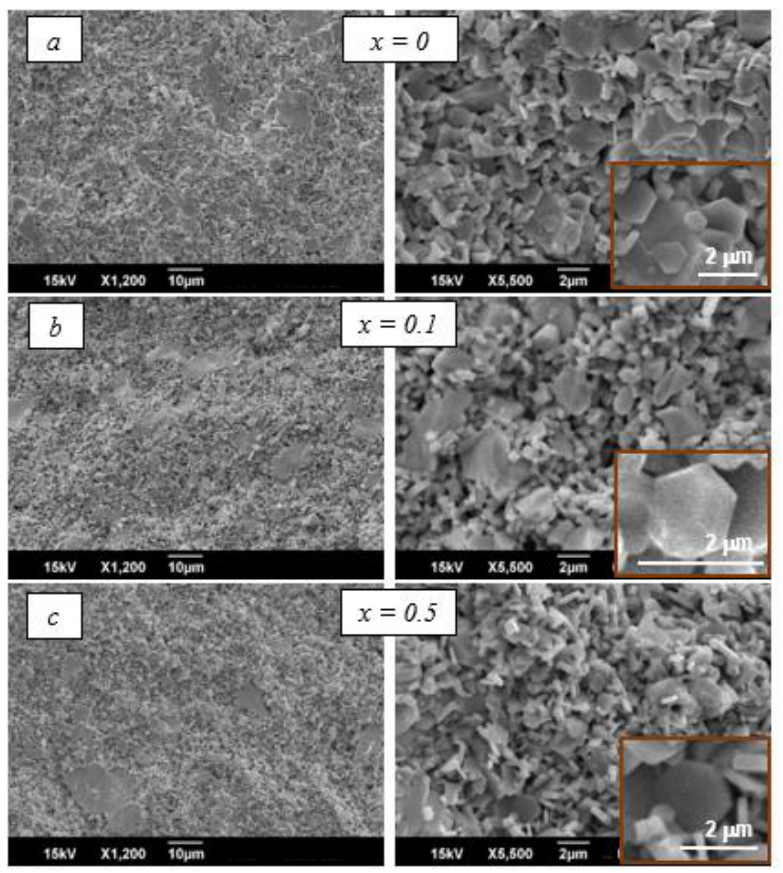
Figure 8. SEM images of ME ceramics 50 wt.% PZTNB‑1 + 50 wt.% Pb1−xLaxFe12−xZnxO19 with ( a ) x = 0, ( b ) x = 0.1, ( c ) x = 0.5.